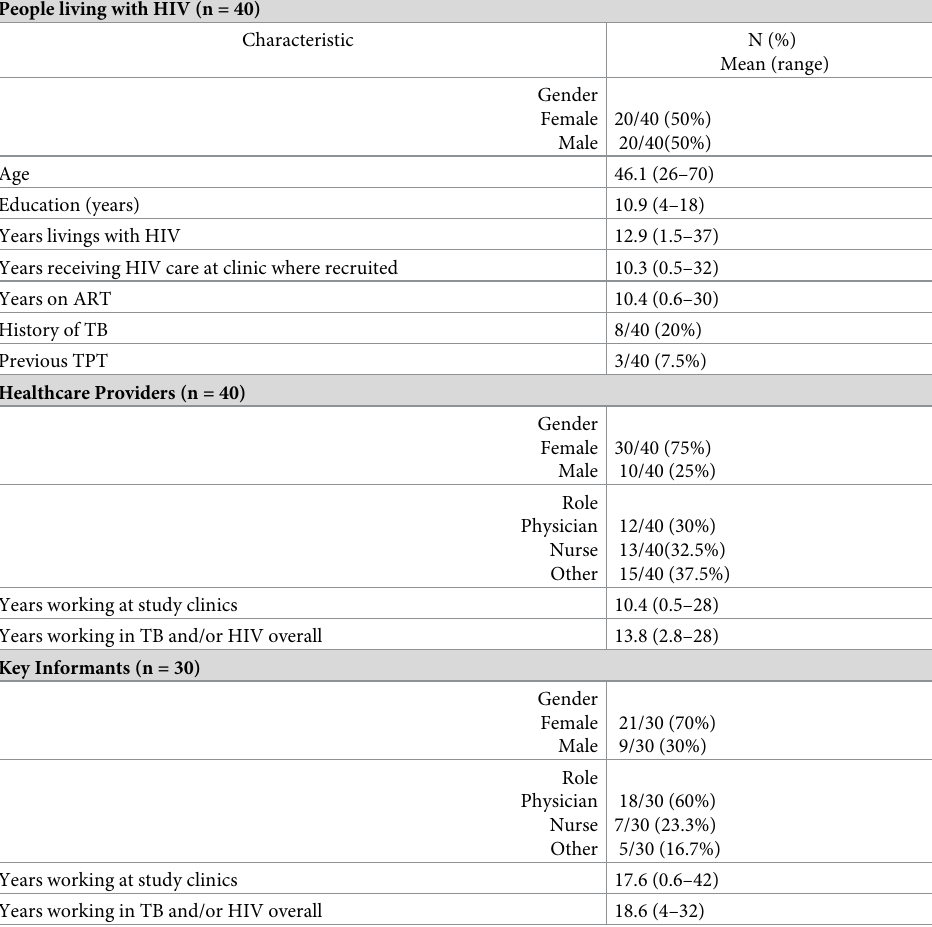
Table 1. Sociodemographic characteristics of the sample (N =